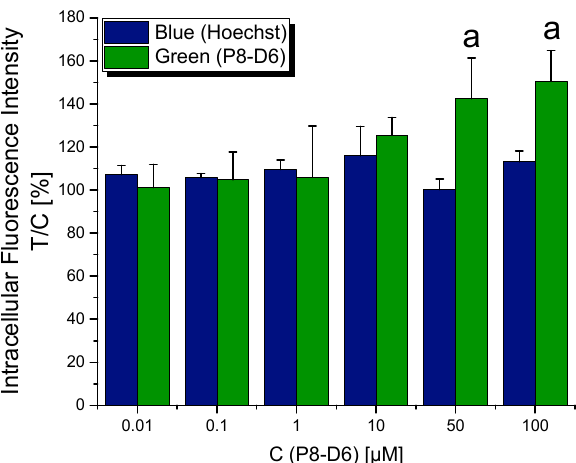
Figure 3. Quantified fluorescence signals of the stained DNA in HT-29 cells after an incubation of 1 h with P8-D6 at concentrations between 0.01 µM and 100 µM, expressed relative to the solvent control. Values are expressed as mean + SD of at least three independent biological experiments. Statistical significances ( p < 0.05) were calculated by applying one-way ANOVA to green/blue test/control values, followed by Fisher’s Least Significant Difference (LSD) test, with “a” indicating a difference to the respective no-effect level with p < 0.05.